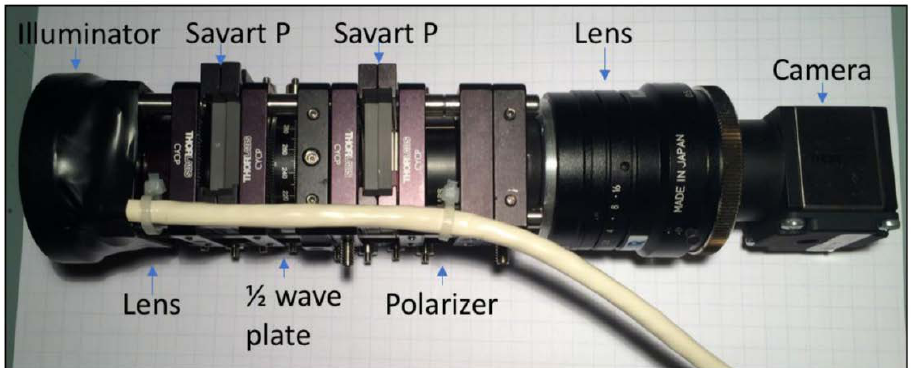
Figure 4. The snapshot Mueller matrix polarimeter used for polarization imaging of the uterine cervix (Reprinted from Ref. [56]).